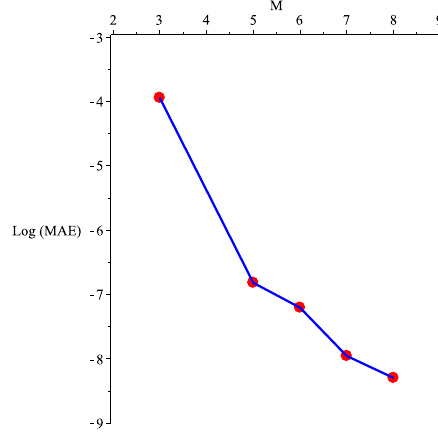
Figure 1. Graph of log 10 ( MAE ) at α = 1.85 for Problem